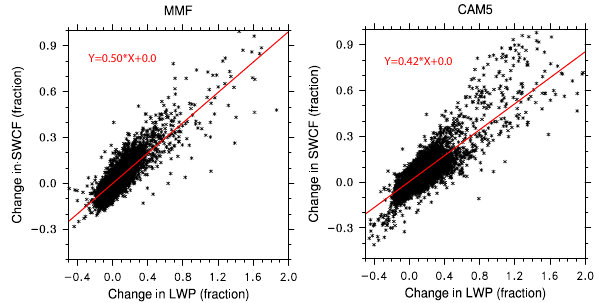
15Y=0.50*X+0.0 Figure Fig. 15. Scatter plots and regressions of the relative changes [(PD- PI)/PI] in annual-mean shortwave cloud forcing (SWCF) versus the relative changes in annual-mean liquid water path (LWP) in both the MMF (left panel) and CAM5 (right panel) from PI to PD. Annual mean model data are sampled on each GCM grid column from 60 ◦ S to 60 ◦ N. LWP in CAM5 includes contributions from both large- scale and convective clouds. Red lines and equations are from the linear